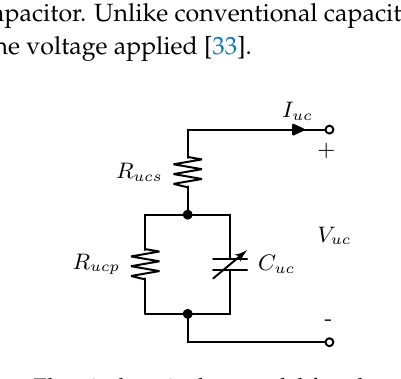
Figure 5. Electrical equivalent model for